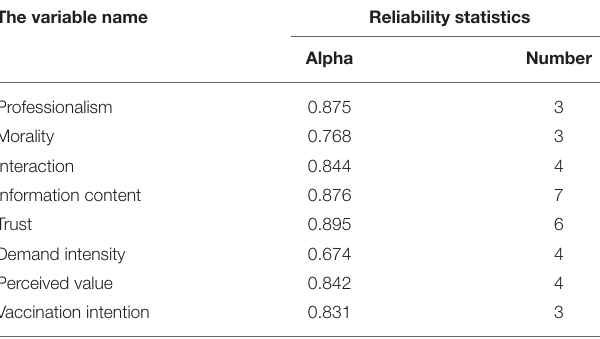
TABLE 2 | Reliability analysis of each dimension.